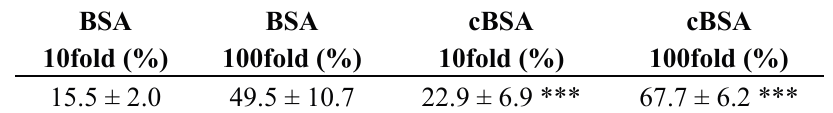
Table 3. Inhibitory effects of free bovine serum albumin (BSA) and cBSA. Values are derived from mean of inhibited and uninhibited samples of 3 separate experiments ± standard deviations ( n = 8, each). Statistical analysis was performed via t test (***, p <